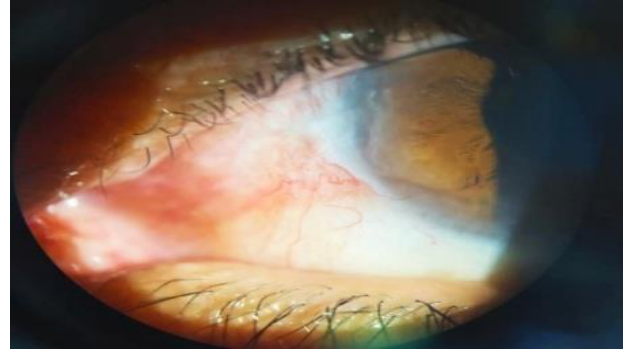
Fig. 7. Conjunctival growth nearly reached the limbus after three weeks of treatment.